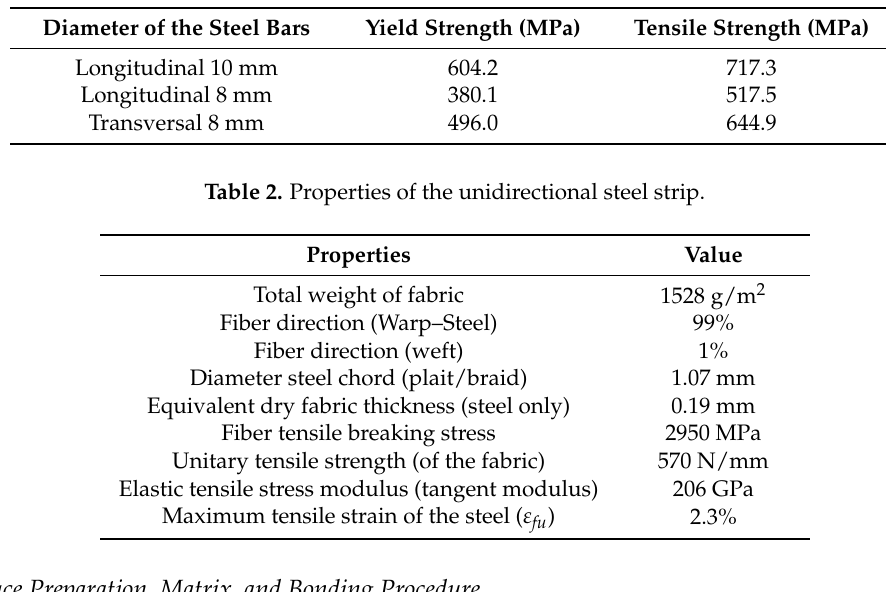
Table 1. Mechanical properties of the internal steel reinforcement.